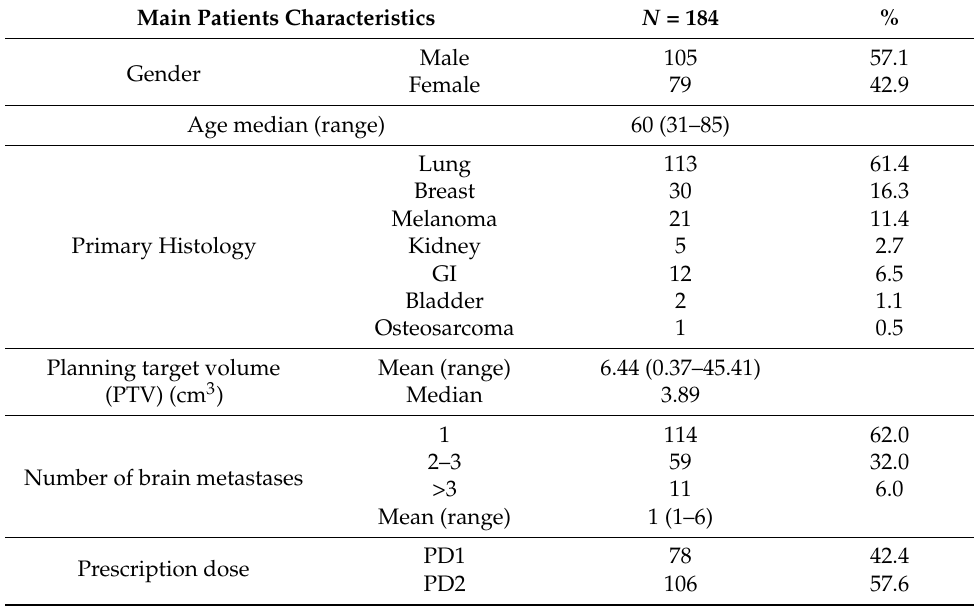
Table 1. Main patients’ characteristics.